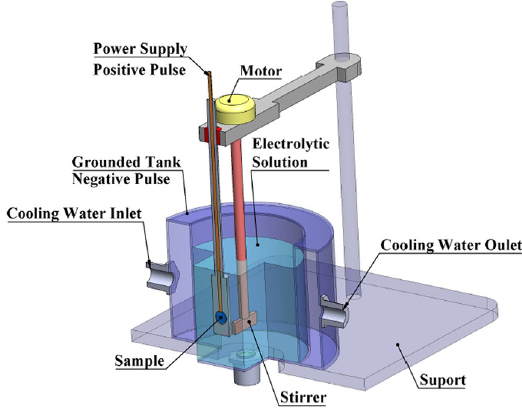
Figure 1. Schematic representation of the treatment cell. After metallographic preparation of cross-sectioned samples, coating thickness was measured using scanning electron microscopy (SEM). Roughness was investigated using profilometry and surface morphology was examined by